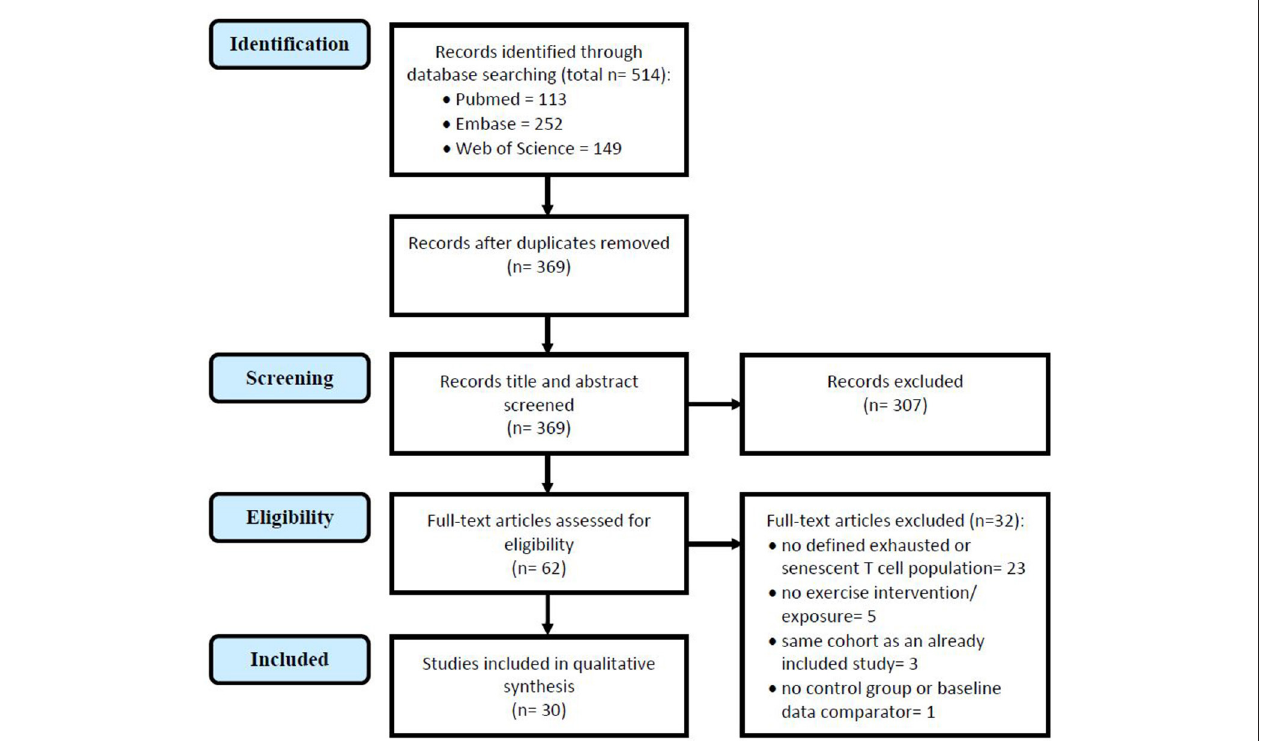
FIGURE 1 | Study selection in accordance with the Preferred Reporting Items for Systematic Reviews and Meta-Analyses (PRISMA) guidelines for systemic reviews (Moher et al., 2009), the above flowchart illustrates the selection process of studies in this review.